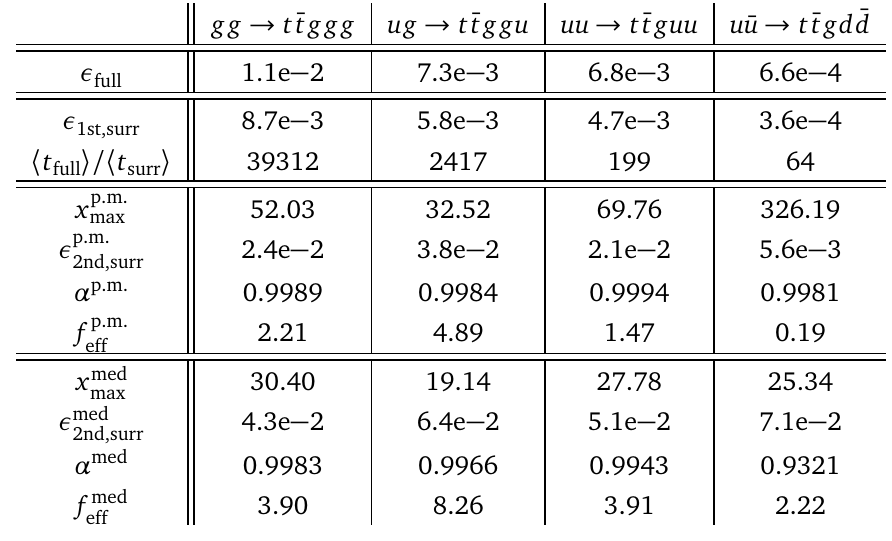
Table 6: Performance measures for partonic channels contributing to t ¯ t + 3 jets pro- duction at the